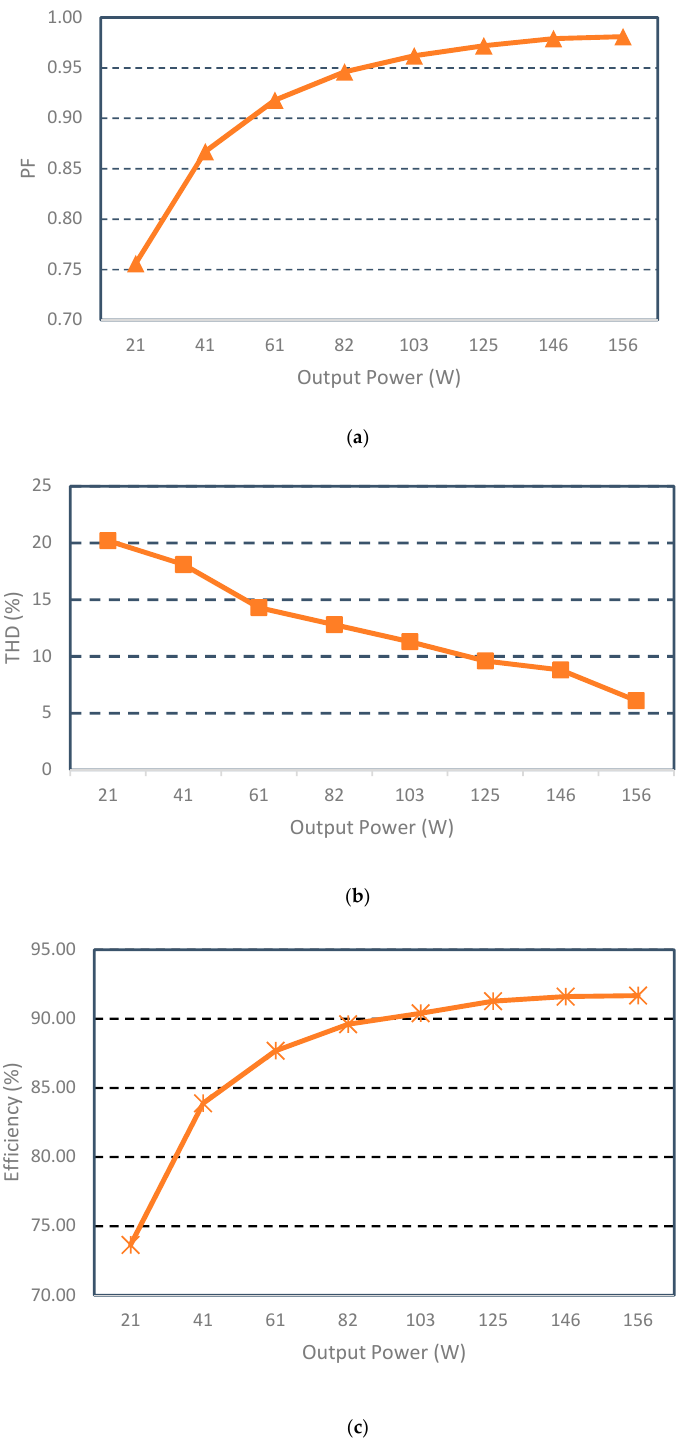
Figure 22. Experimental results of ( a ) PF and ( b ) total harmonics distortion (THD). ( c ) Efficiency with changing power load.